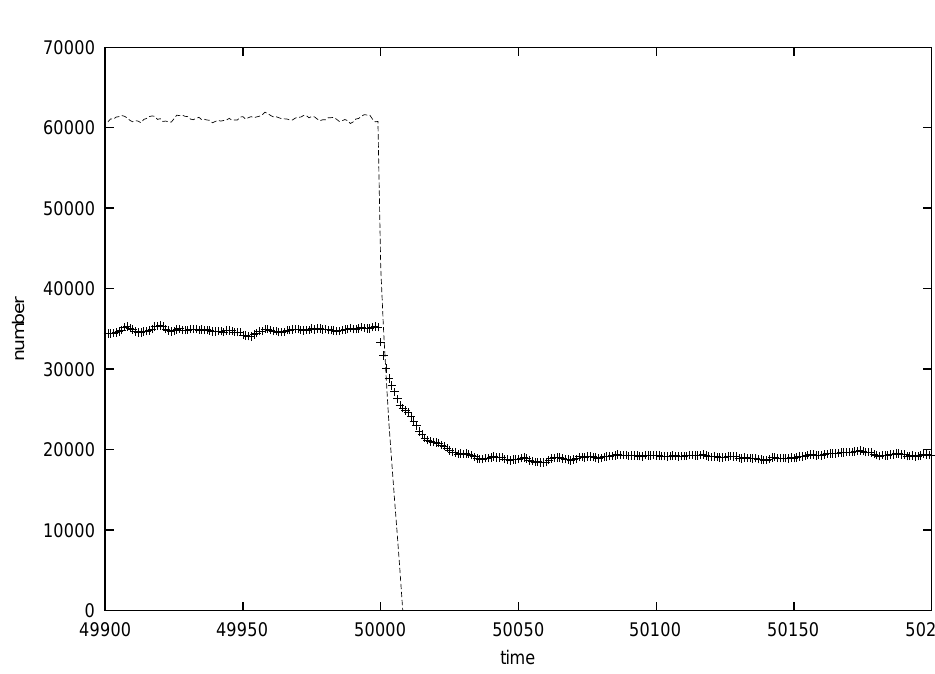
Fig. 5 – Comparison of MP (lines) with SX (crosses) population before and after a sudden change in the environment. For SX, the female birth rate of two was the same as for all MP individuals. ( N max = 400000 , T = 3 , d = 5 , R = 10, one mutation per